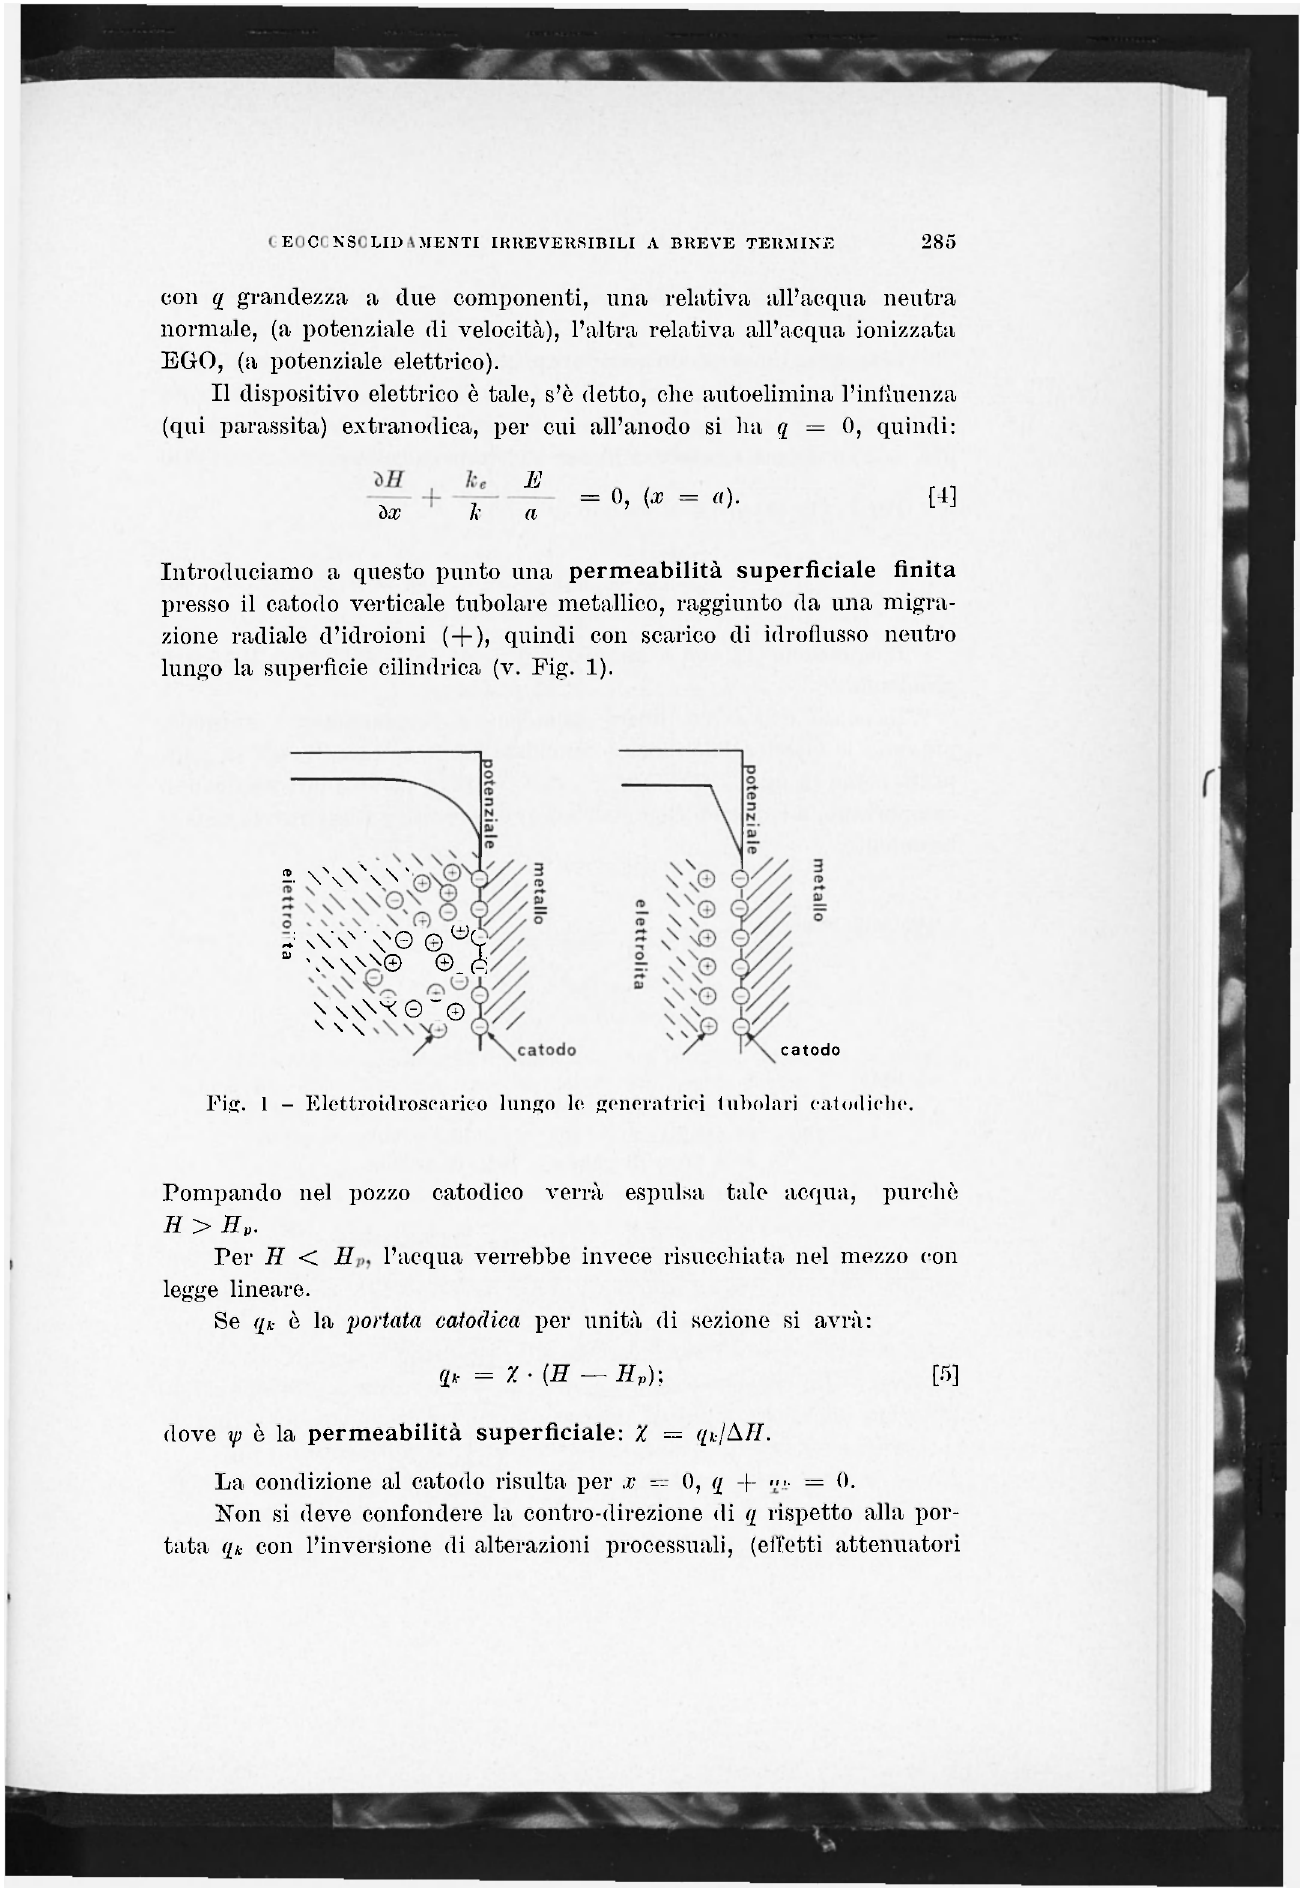
Fig. 1 - Elettroidroscarico lungo le generatrici tubolari